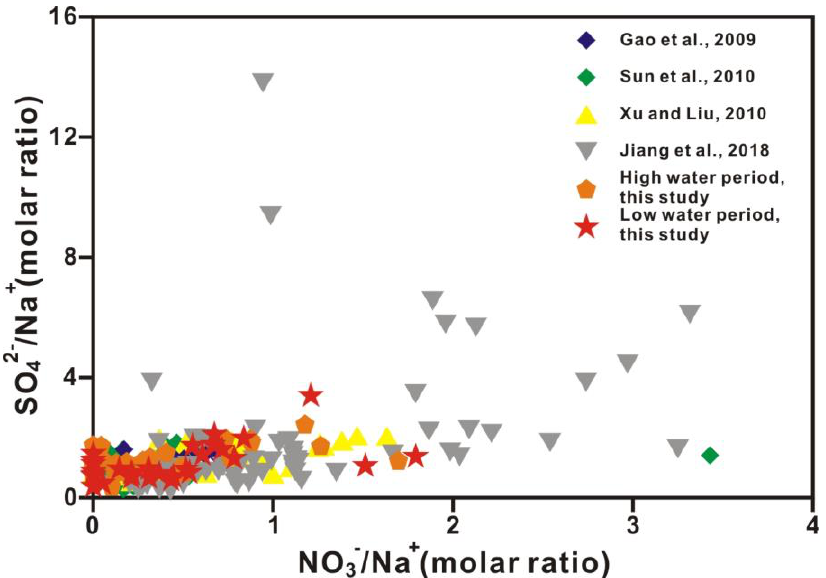
Figure 5. Plots of the molar ratio of SO 42 − /Na + versus the molar ratio of NO 3 − /Na + in Xi River drainage. Refs. (Gao et al., 2009; Sun et al., 2010; Xu and Liu, 2010; Jiang et al., 2018) are cited in figure [2,20,22,28].